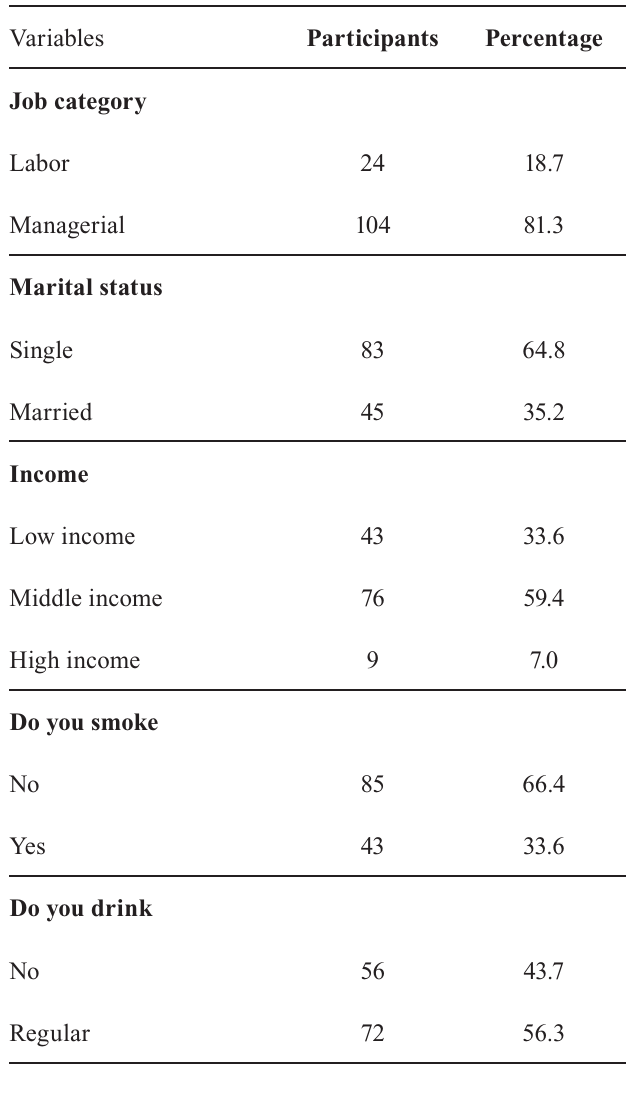
TABLE I - D emographic characteristics of participants’